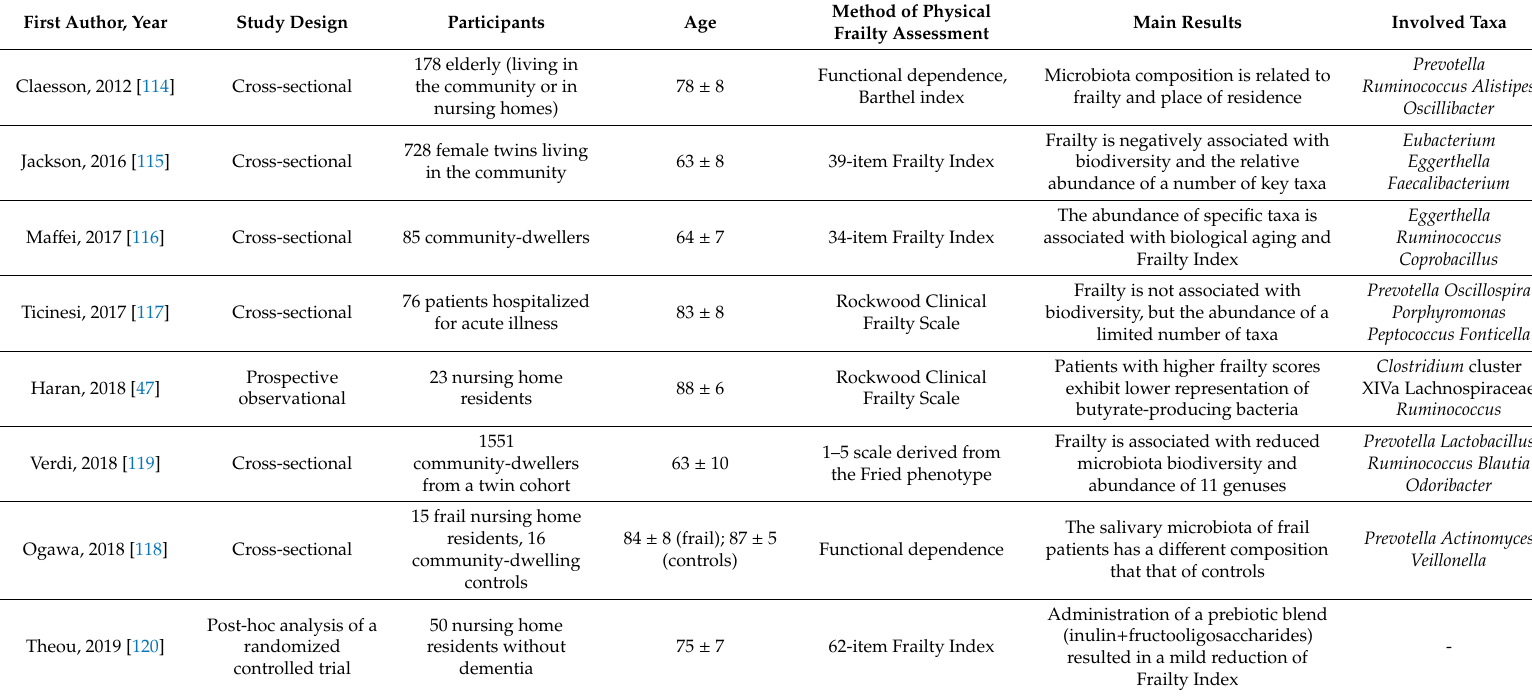
Table 2. Overview of the main human studies that investigated the association between fecal microbiota composition and physical